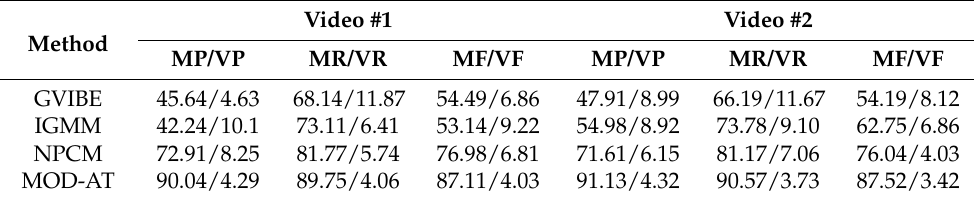
Table 5. Comparison of indicators of MOD-AT algorithm.